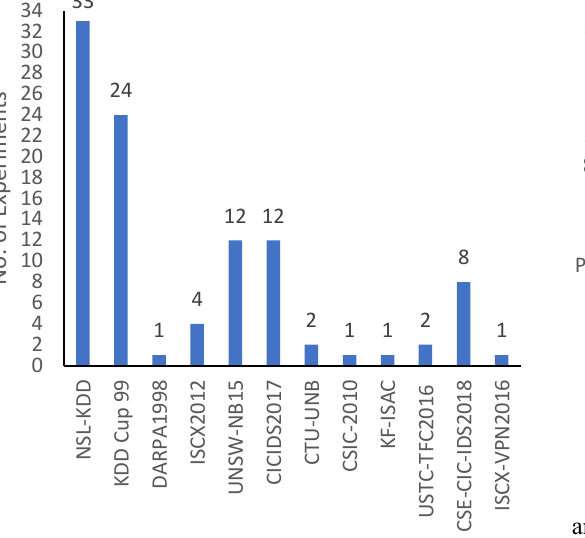
Figure 4 Evaluation